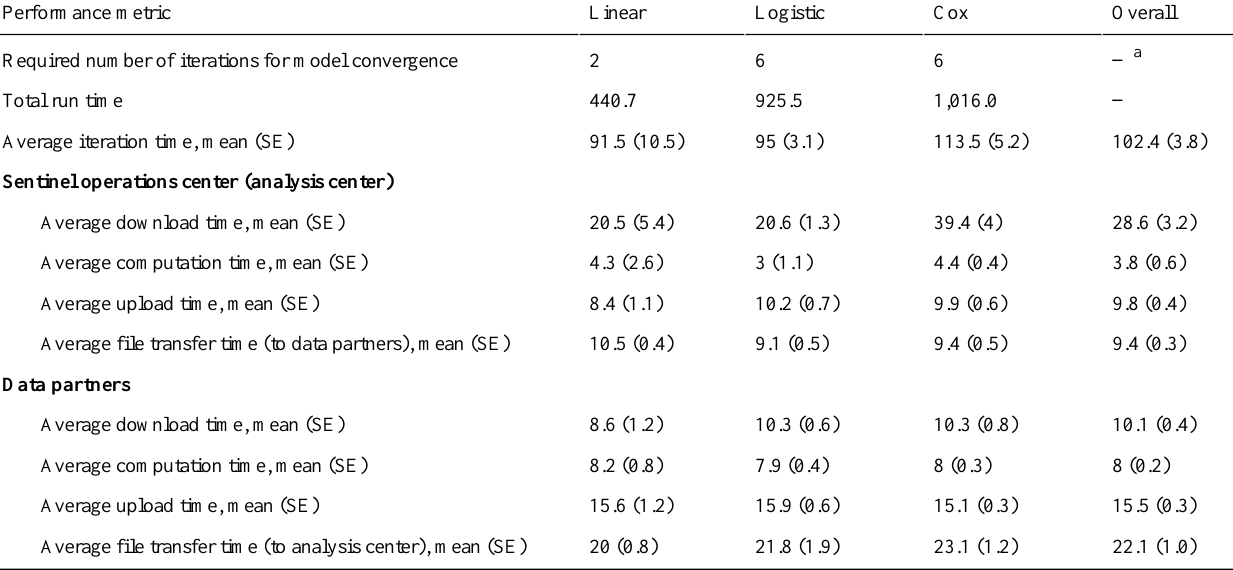
— a 662Required number of iterations for model convergence